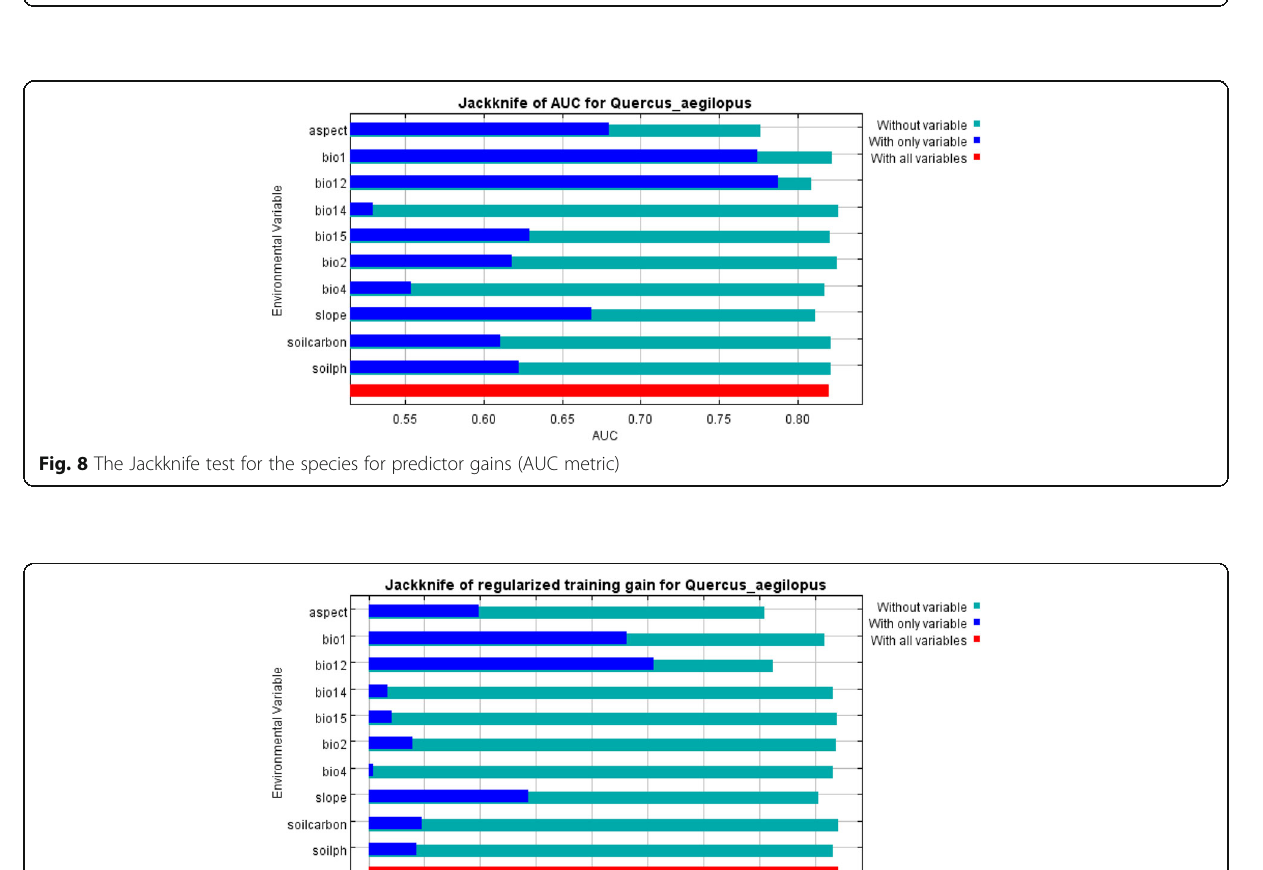
Fig. 7 Model performance, mean AUC and standard deviations